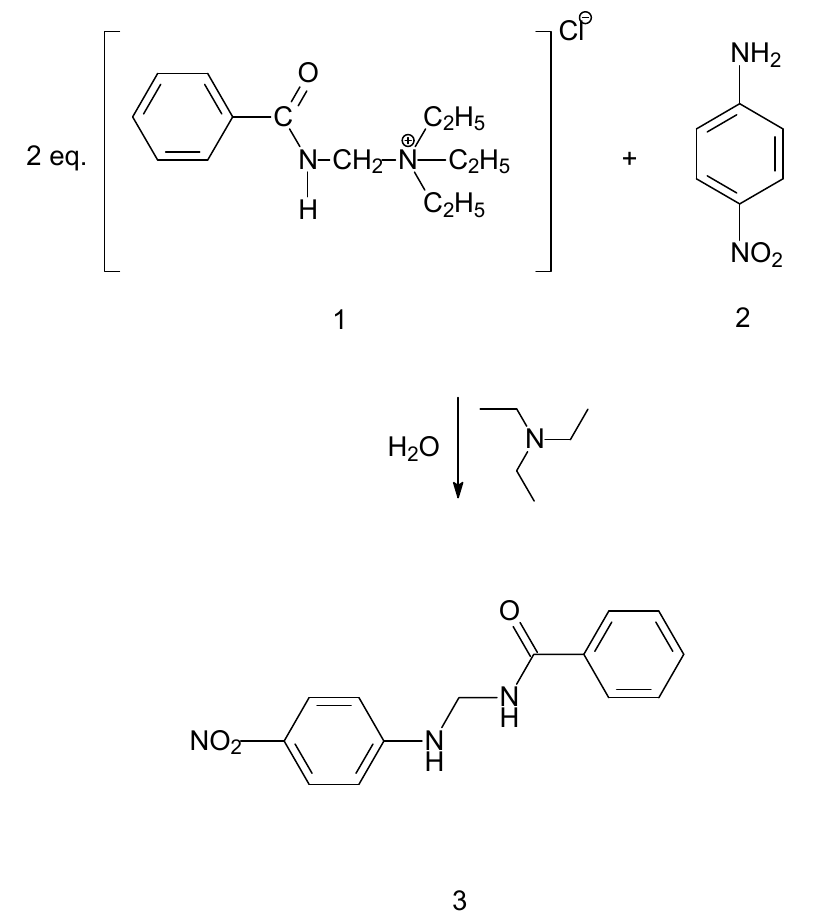
Figure 1. Reaction scheme for the tittle